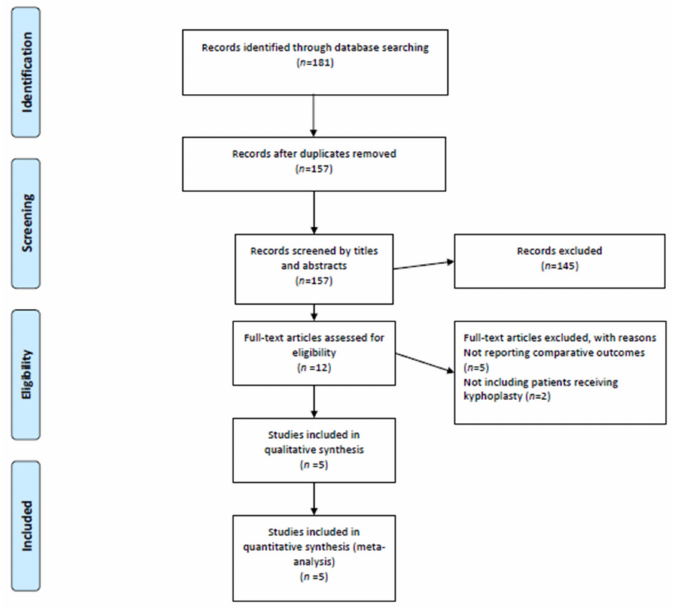
Figure 1. PRISMA flowchart diagram. We initially extracted 181 potential references. Screening the titles and abstracts yielded 12 full-text articles, the eligibility of which was assessed. Eventually, 5 studies were included for qualitative and quantitative syntheses. PRISMA, Preferred Reporting Items for Systematic Reviews and Meta-Analyses.